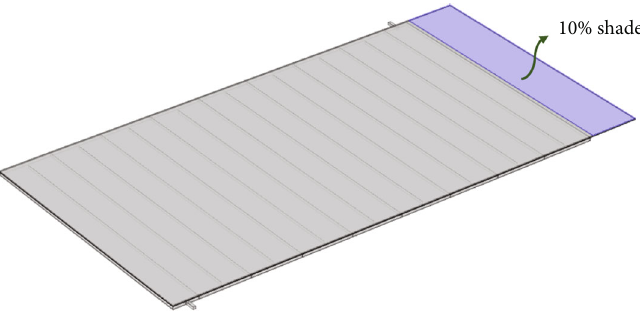
Figure 2: Three-dimensional computational view of the PVT system with 10% shaded area.